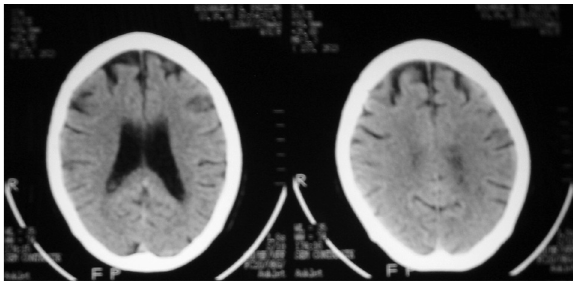
Figure 1. Brain CT showing frontal atrophy.